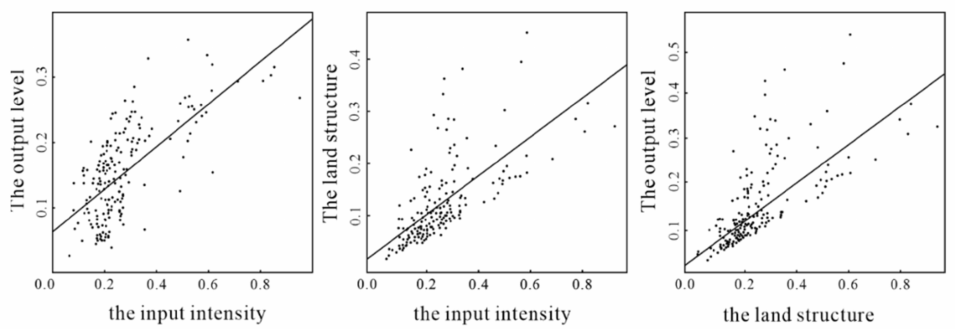
Figure 9. The left figure is the correlation between the output level and the input intensity, the middle figure is the correlation between the land structure and the input intensity, and the right figure is the correlation between the output level and the land